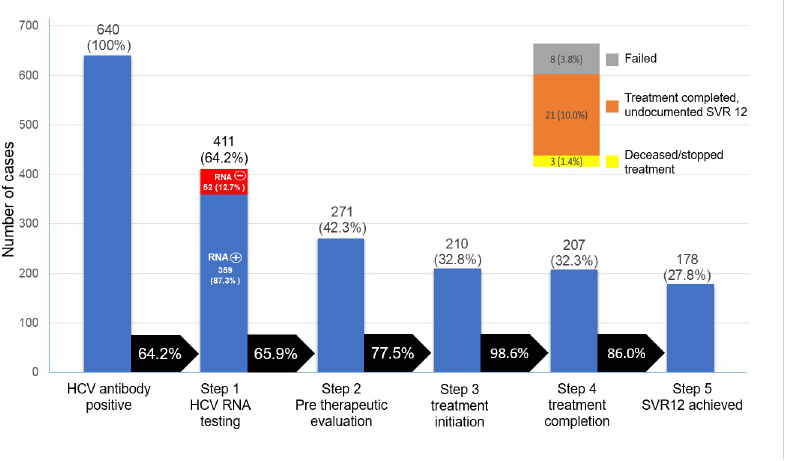
Fig 1. HCV care cascade for HCV diagnosed HIV-infected patients in care. Arrows represent the proportion of patients in the previous stage of the cascade that progressed to the next stage of care. Note: SVR = sustained virological